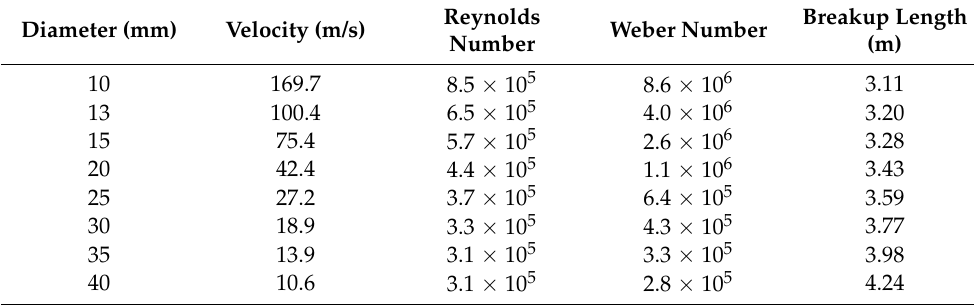
Table 2. Parameters of the metal